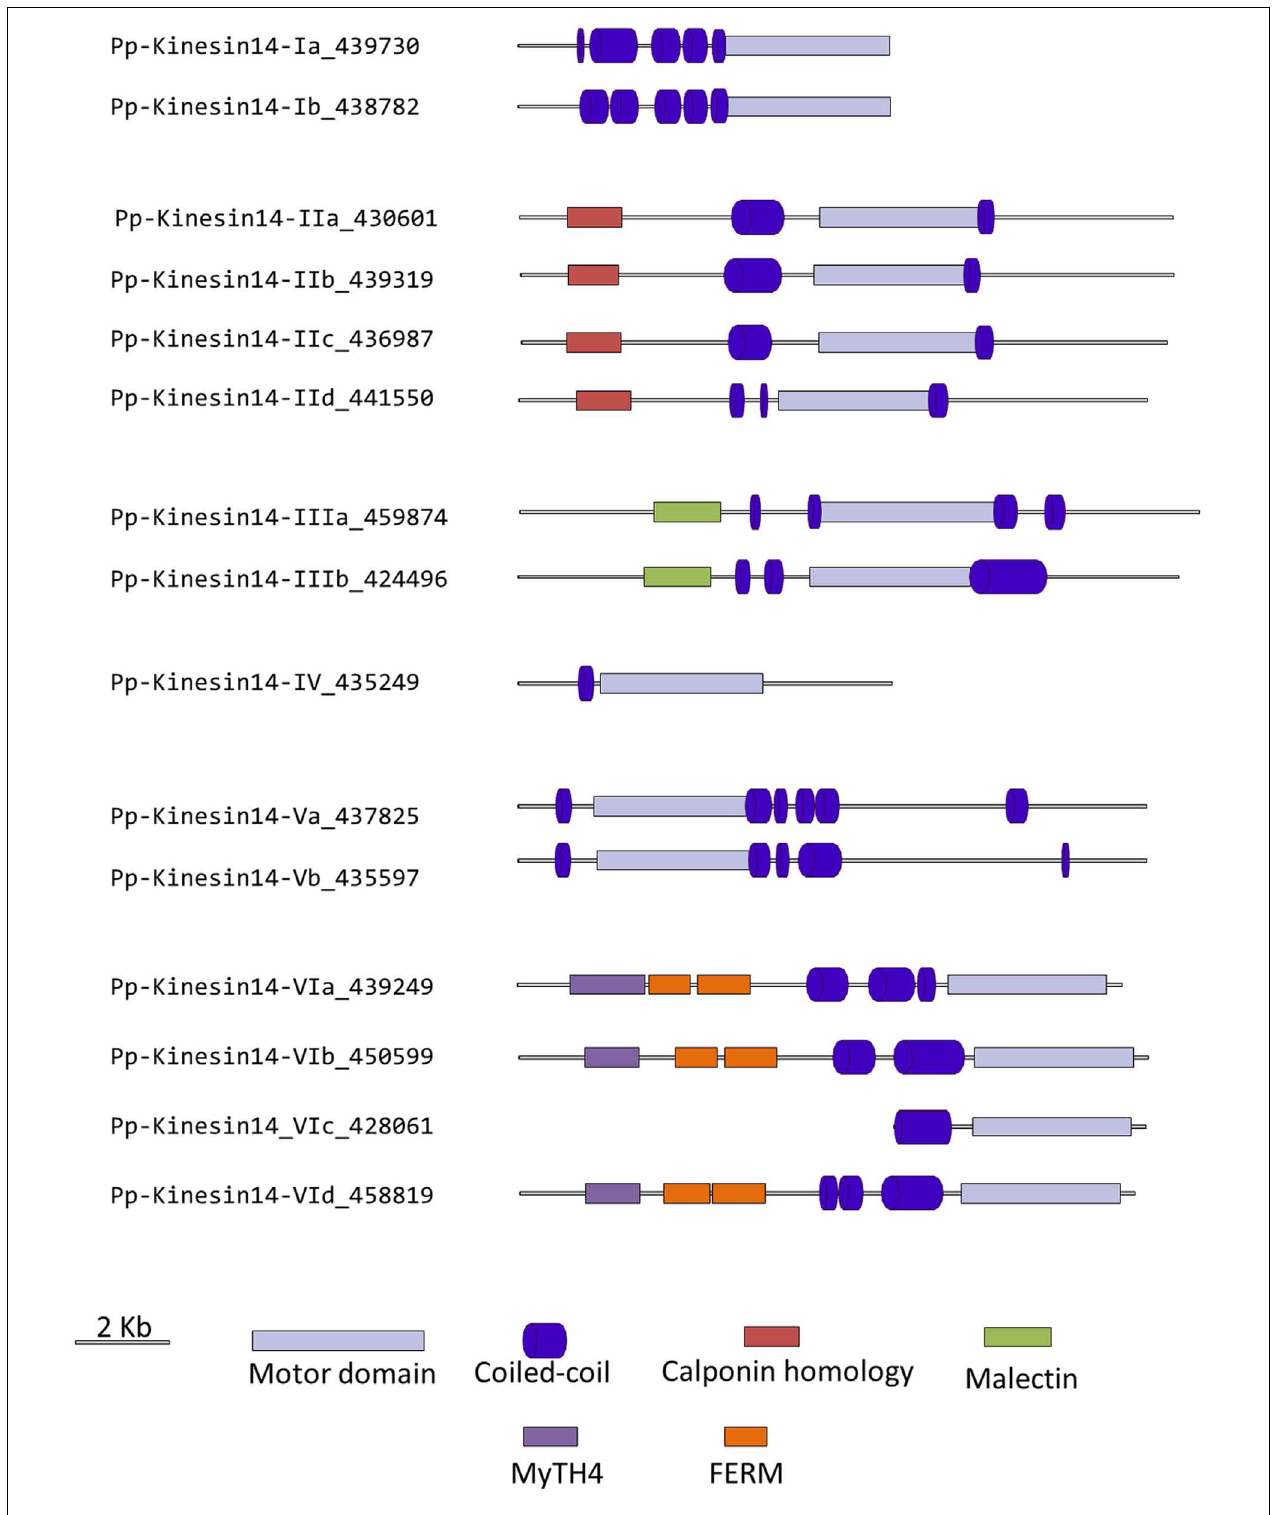
domains allow binding to carbohydrate such as di-glucose; and MyosinTail Homology domain 4 (MyTH4) and FERM domains (motif named after proteins that contains it: 4.1 protein, Ezrin, Radixin, Moesin) also called talin-like region, are known to bind